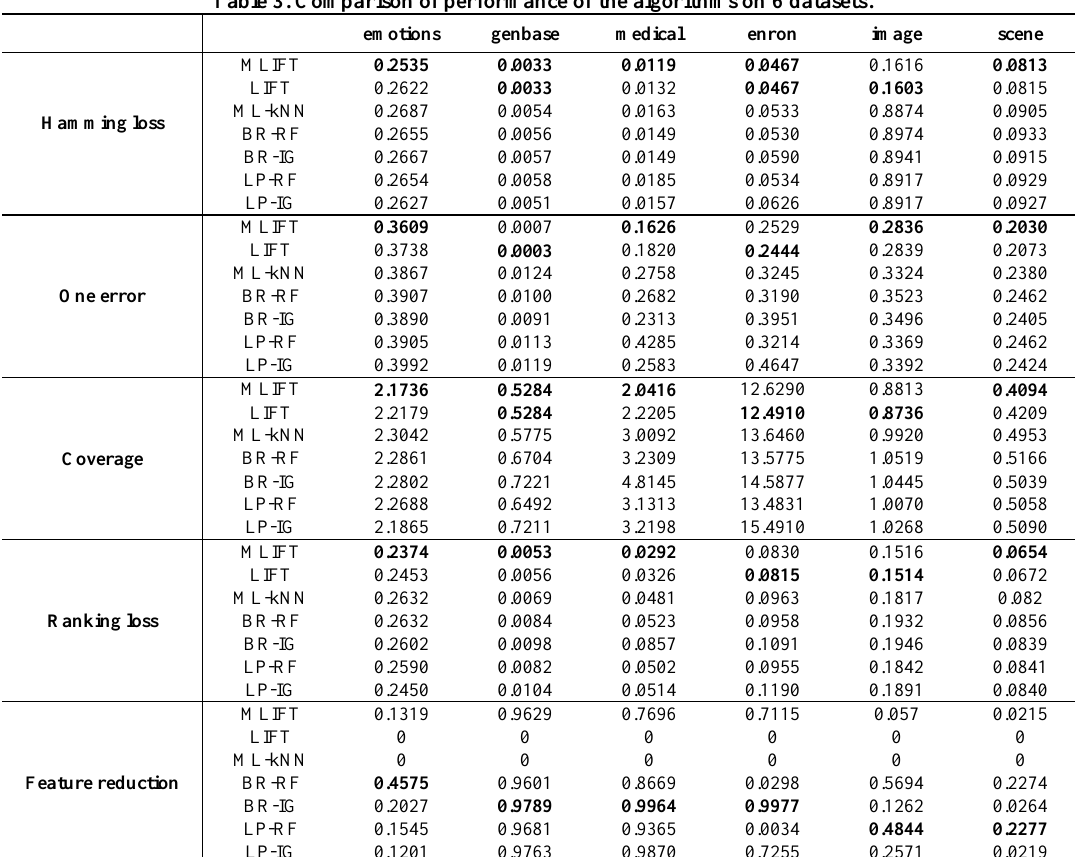
Table 3. Comparison of performance of the algorithms on 6